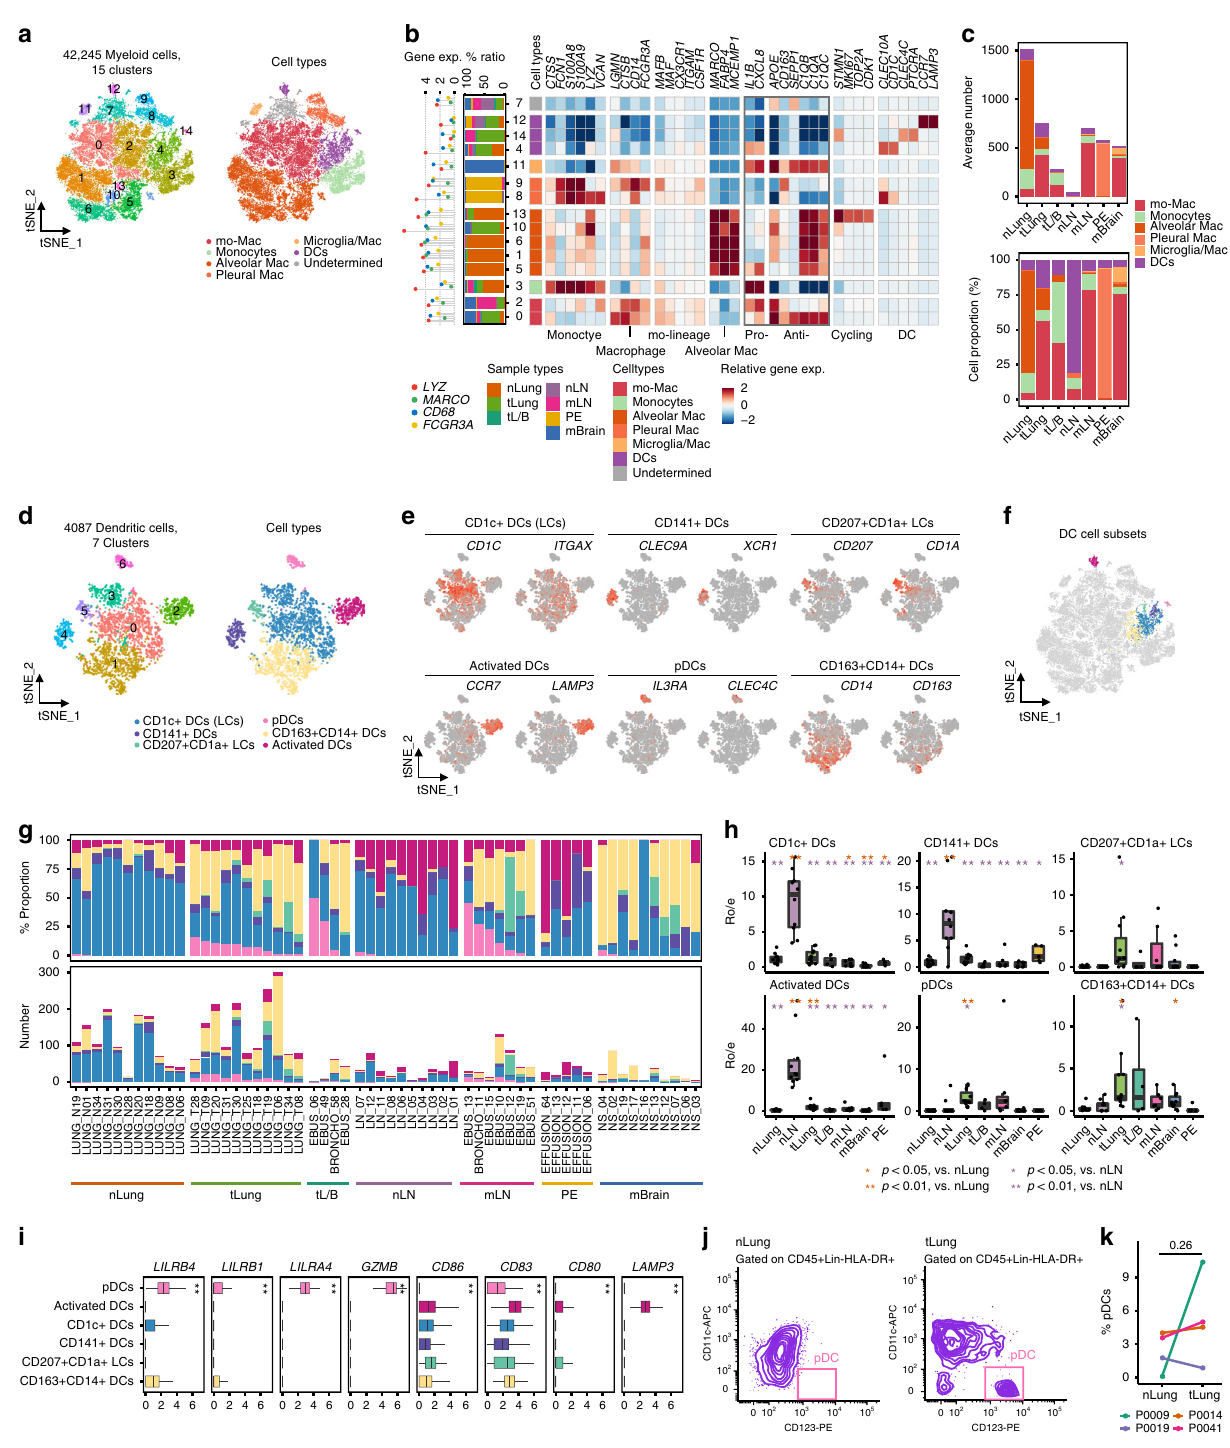
clustering of 27,657 B cells revealed 14 clusters (Fig. 5a) con- verging to fi ve differentiation states 9,50,51 , which were represented as follicular B cells, plasma B cells expressing immunoglobulin gamma (IgG), mucosa-associated lymphoid tissue-derived plasma B cells expressing IgA and joining chain, granzyme B-secreting B cells, and germinal center (GC) B cells (Fig. 5a, Supplementary Fig. 7a, b). Speci fi cally, GC B cells 50 were separated into either dark or light zone cells with distinct transcriptional programs for proliferation or activation, respectively 52 (Supplementary Fig.